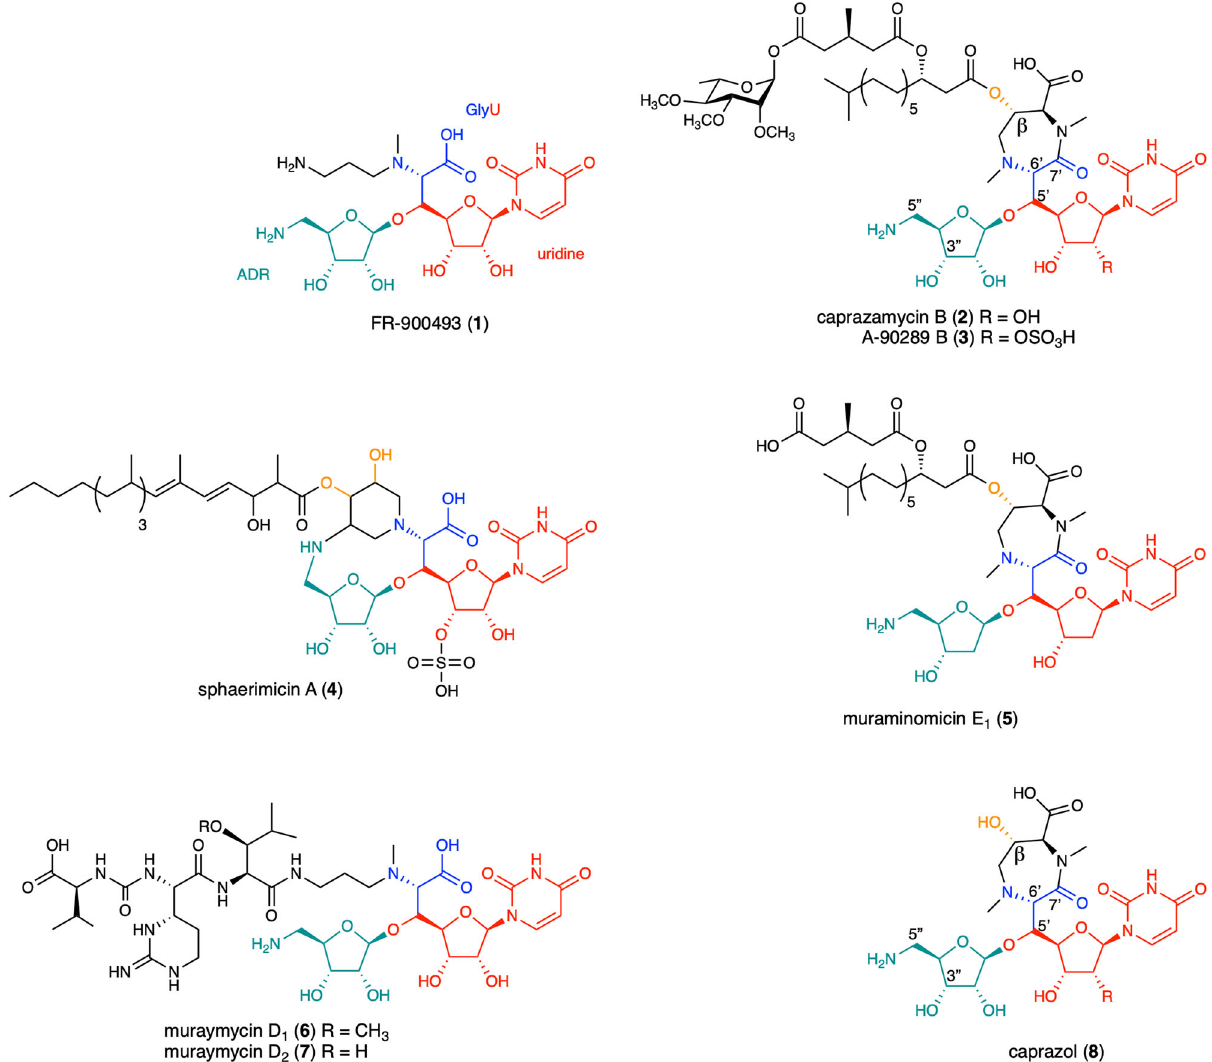
Fig. 1 Chemical structures of representative MraY inhibitors. Nucleoside antibiotics are composed of some characteristic moieties: uridine colored red, 5 ″ -amino-5 ″ -deoxyribose (ADR) colored green, the glycine moiety colored blue and the β -hydroxyl group colored orange. The numbering system referred to in the text is